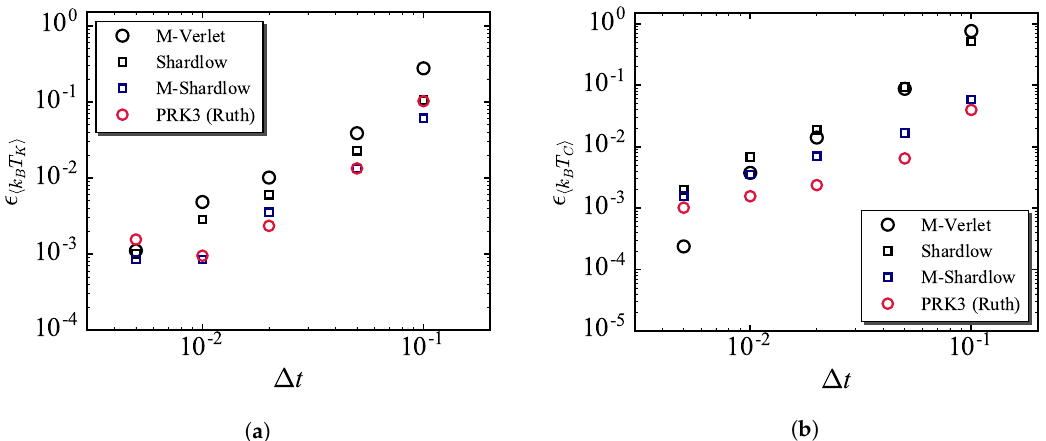
Figure 1. Errors in ( a ) ( k B T ) integration schemes.